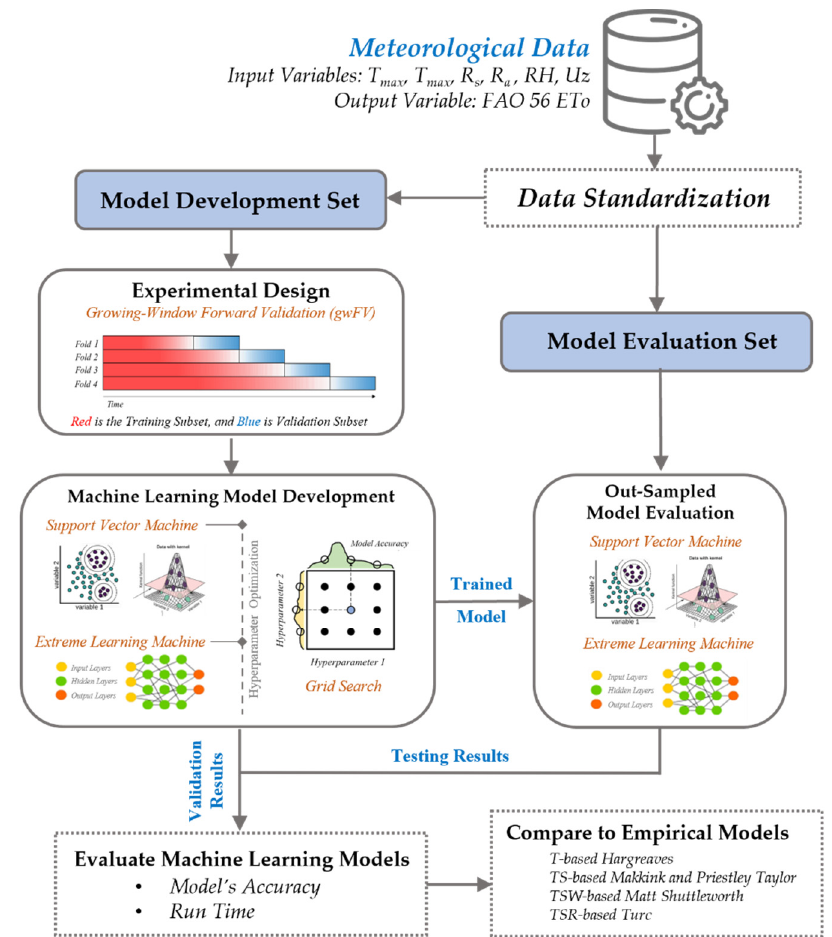
Figure 2. Methodology framework for developing SVM and ELM models for the estimation of daily ETo. Image Sources: Schematic Diagram of SVM (Rhys, 2020), ELM (van Veen and Leijnen, 2019), and grid search (Pilario et al., 2020).